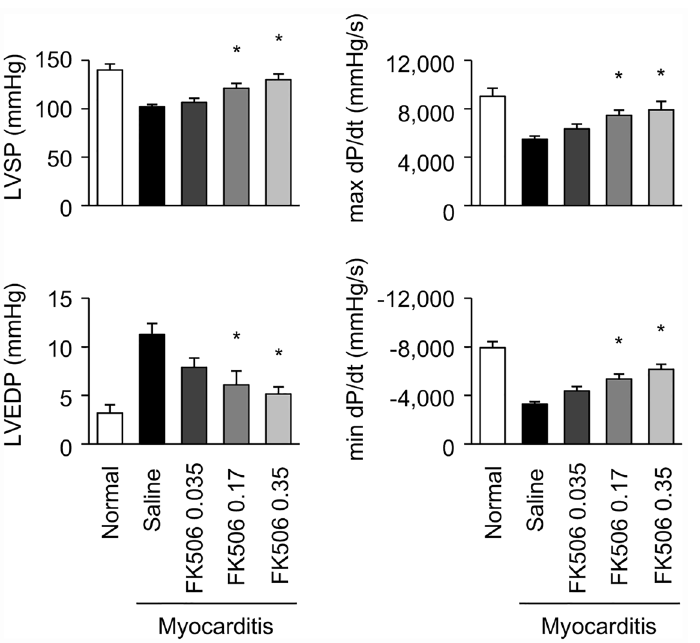
Fig 1. Effects of free FK506 on hemodynamic parameters in the rat EAM model. Quantitative data of hemodynamic parameters, including left ventricular systolic pressure (LVSP), left ventricular end-diastolic pressure (LVEDP), max dP/dt and minimum dP/dt, on day 21 after immunization. Drugs were intravenously administered on days 14 and 17 after immunization. Rats were divided into Normal, EAM with saline treatment and EAM with free FK506 (0.035, 0.17 or 0.35 mg/kg) treatment groups (N = 5 – 15 in each group). Data are expressed as the mean ± SEM. * P < 0.05 versus the saline treated group.